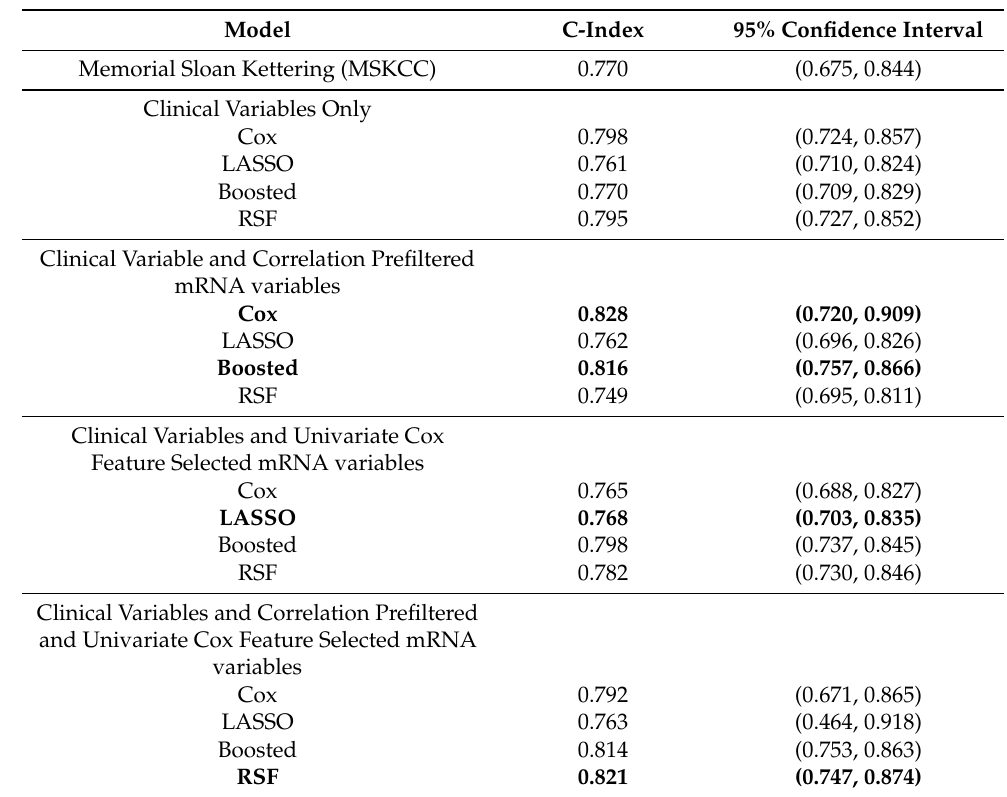
Table 2. Bootstrapped C-indices. The top performing pipelines for each statistical model (namely CPH, LASSO Cox, Boosted Cox, and RSF) are highlighted in